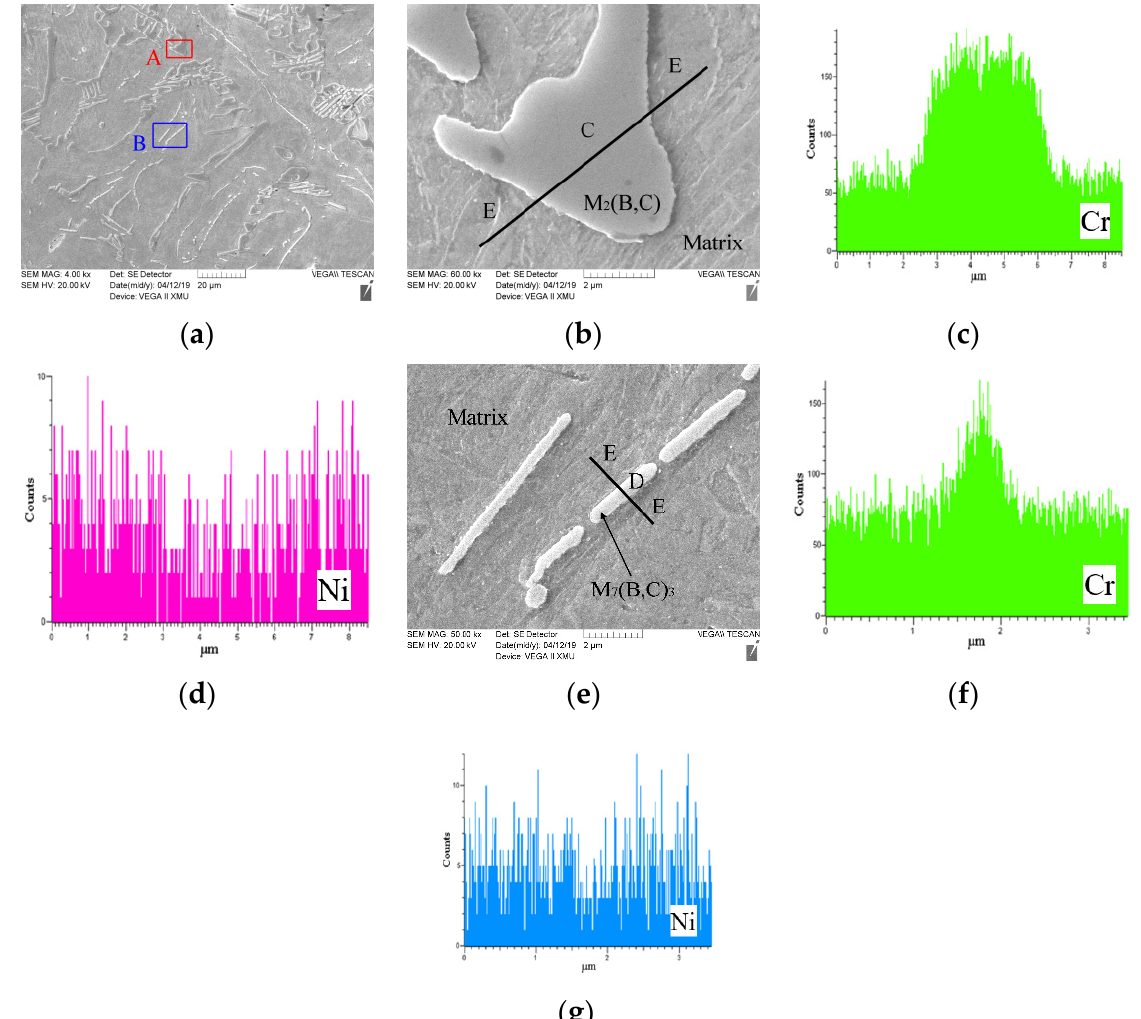
Figure 3. The as-cast microstructure and EDS analyses of boron-bearing stainless steel: ( a ) the microstructure morphology of as-cast boron-bearing stainless steel; ( b ) displaying microstructure morphology of A area: C-borocarbide [M 2 (B,C)], E-matrix; ( c , d ) displaying the distributions of chromium and nickel elements along black line in ( b ), respectively; ( e ) displaying the morphology of B area: D-borocarbide [M 7 (B,C) 3 ], E-matrix; ( f , g ) displaying the distributions of chromium and nickel elements along black line in ( e ), respectively.